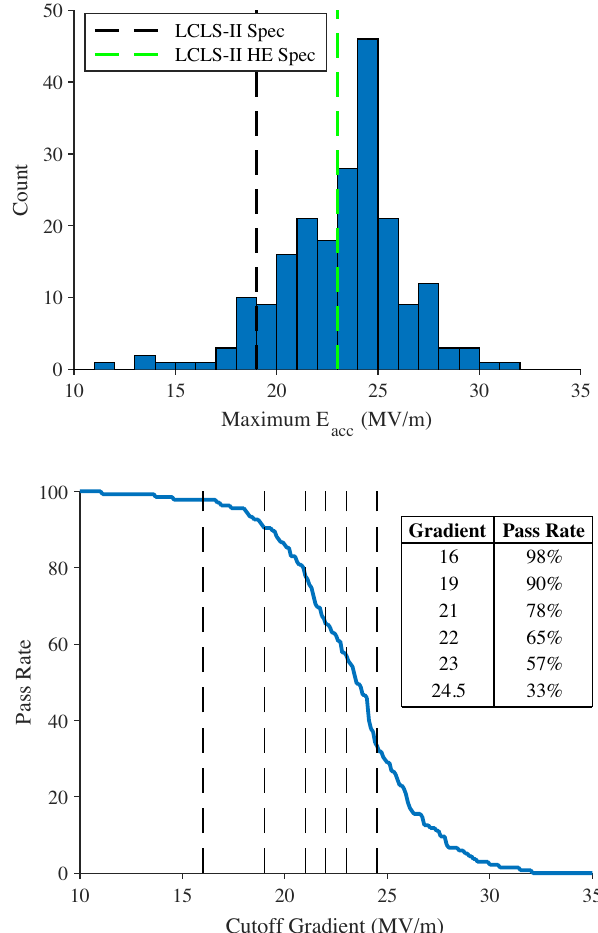
FIG. 2. Statistics for vertical testing of production L2 cavities, showing that the gradient reach was not sufficient for HE. For L2, the minimally accepted gradient in VT was 19 MV = m; for HE it is 23 MV =